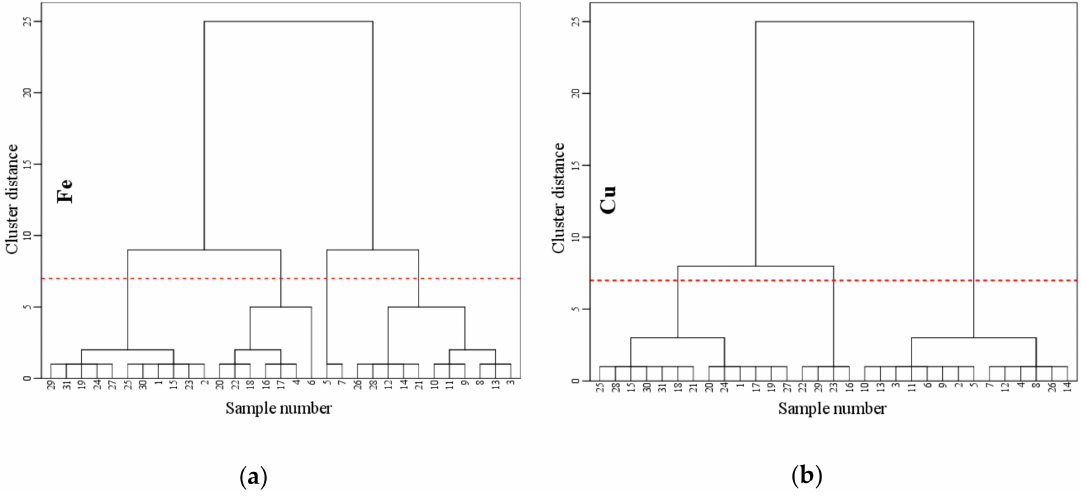
Figure 6. System cluster pedigree chart: ( a ) Fe; ( b )